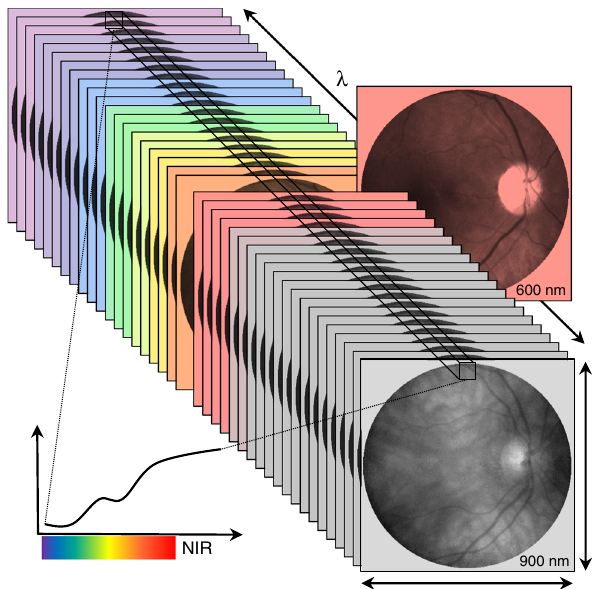
Fig. 1 Principle of retinal hyperspectral (HS) imaging. In HS imaging a narrow bandwidth tunable light source illuminates the retina and the re fl ected light from the retina is collected by an image sensor. The different frames of the hyperspectral re fl ectance cube are obtained by scanning the source wavelengths. Therefore, each HS image has both spatial and spectral information, i.e., each spatial locus has an associated spectrum when viewed across the available wavelengths. NIR =